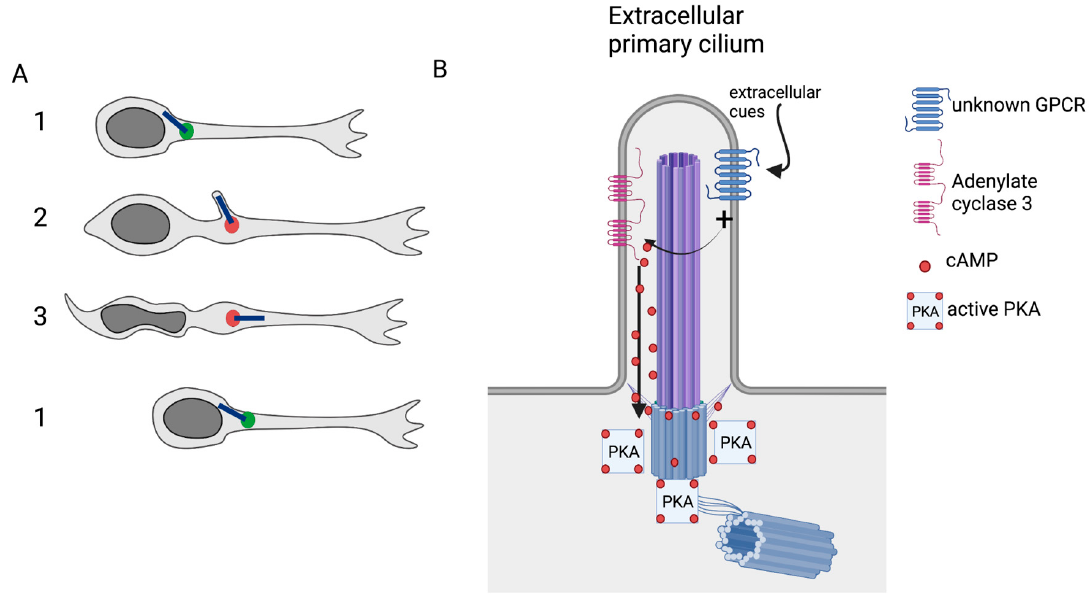
Figure 3. How does the PC control neuronal migration? ( A ) Dynamics of the PC and occurrence of the hotspot (red dot) during cyclic saltatory neuronal migration [13,14]. ( B ) While the PC is extracellularly exposed, an extracellular cue might activate a ciliary GPCR (G protein coupled receptor) coupled to Gs, which activates adenylate cyclase 3, leading to cAMP (cyclic adenosine monophosphate) production. The PC concentrates the cAMP that diffuses to the centrosome, where it activates PKA (protein kinase A), leading to phosphorylation of targets regulating neuronal migration. This cyclical emergence of the PC in migrating neurons thus appears to be present at least in embryonic interneurons [12] and rostral migratory stream neurons [13],